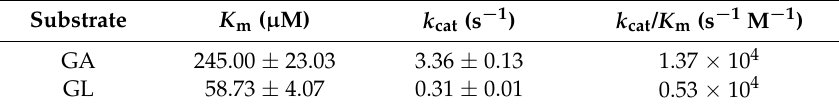
Table 1. Kinetic parameters of Bs-YjiC toward GA and GL.